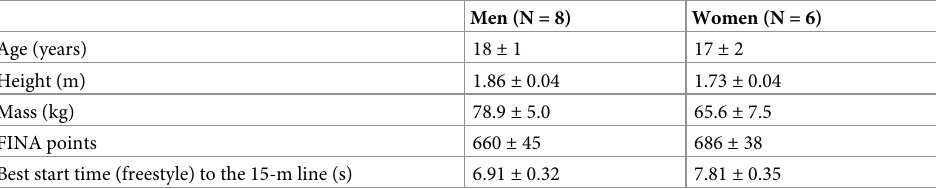
Table 1. Characteristics of included participants (mean ± standard deviation) as acquired by means of anthropo- metrical measurements (mass and height) and personal communication with the trainer (age).